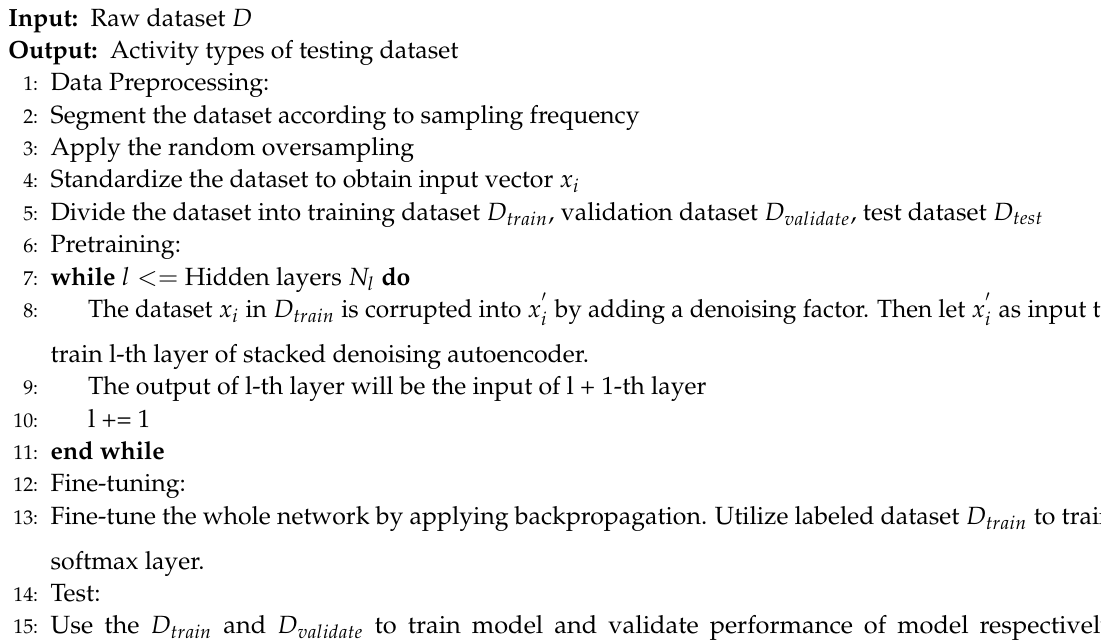
Algorithm 1 Human activity recognition method with